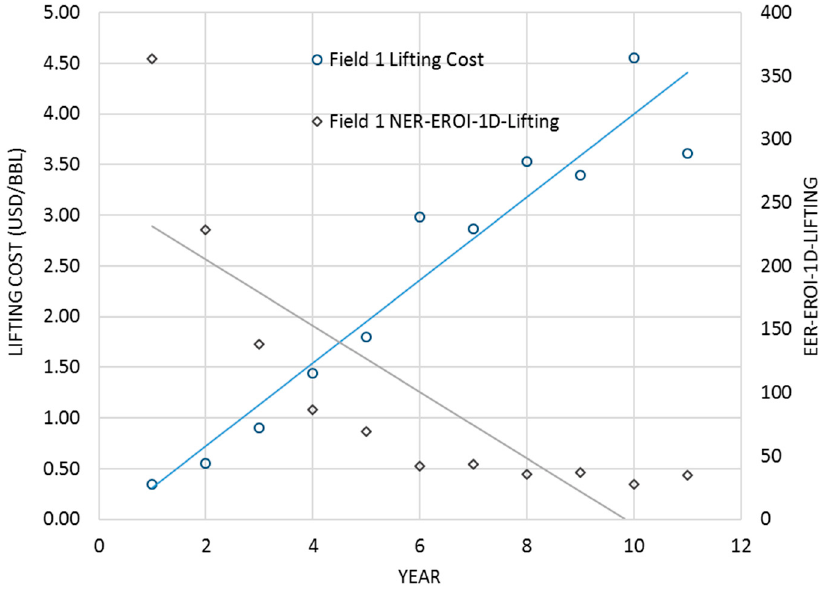
Figure 11. Lifting Costs and NER-EROI-1d Lifting vs. Time for Field 1.